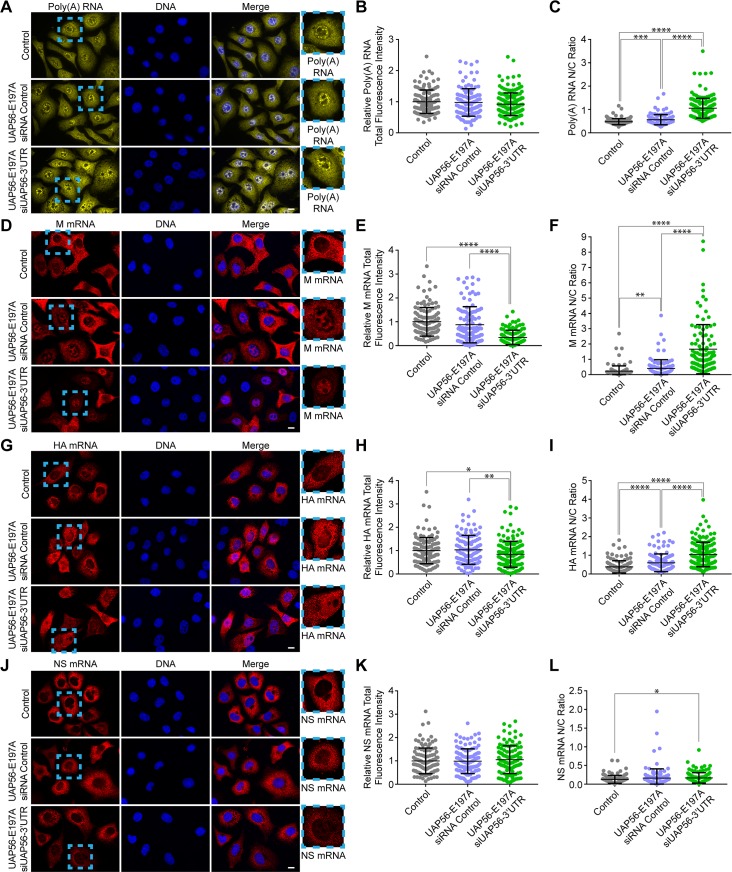
Compound 2 activity phenocopies down-regulation of the mRNA export factor UAP56.A549 cells or A549 cells stably expressing UAP56 E179A mutant were untreated or treated with control siRNA or with siRNA targeting the 3’UTR of UAP56 to knockdown endogenous UAP56 mRNA. Cells were then infected with WSN at MOI 2 for 8h followed by RNA-FISH to detect poly(A) RNA (A-C) or smRNA-FISH to detect M (D-F), HA (G-I), and NS (J-L) mRNAs. For B-C (C, n = 128 cells; UAP56-E197A+siRNA Control, n = 117 cells; UAP56-E197A_siUAP56-3’UTR, n = 170 cells). For E-F (C, n = 121 cells; UAP56-E197A+siRNA Control, n = 106 cells; UAP56-E197A_siUAP56-3’UTR, n = 108 cells). For H-I (C, n = 124 cells; UAP56-E197A+siRNA Control, n = 118 cells; UAP56-E197A_siUAP56-3’UTR, n = 151 cells). For K-L (C, n = 113 cells; UAP56-E197A+siRNA Control, n = 119 cells; UAP56-E197A_siUAP56-3’UTR, n = 115 cells). Graphs show data points and mean +/- SD. *p<0.05, **p<0.01, ***p<0.001 ****p<0.0001.